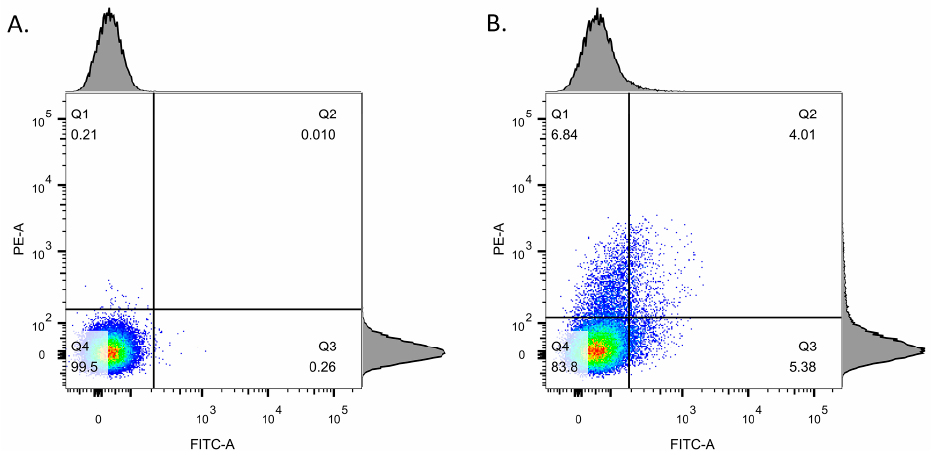
Figure 1. The gating strategy of E. coli O104:H4 11-3088 ∆ stx :: gfp :: amp r ( p 1302:: rfp :: chl r ) with or without MMC induction. ( A ) Dot plot of the negative control without MMC induction. ( B ) Dot plot of the sample induced with MMC for 4.5 h. Gating as represented by reference lines divided cell populations based on the fluorescent signal: Q1, RFP + , GFP − ; Q2, RFP + , GFP + ; Q3, RFP − , GFP + ; Q4, RFP − , and GFP − . The gating was set to include 99.5% of the cells of the negative control.